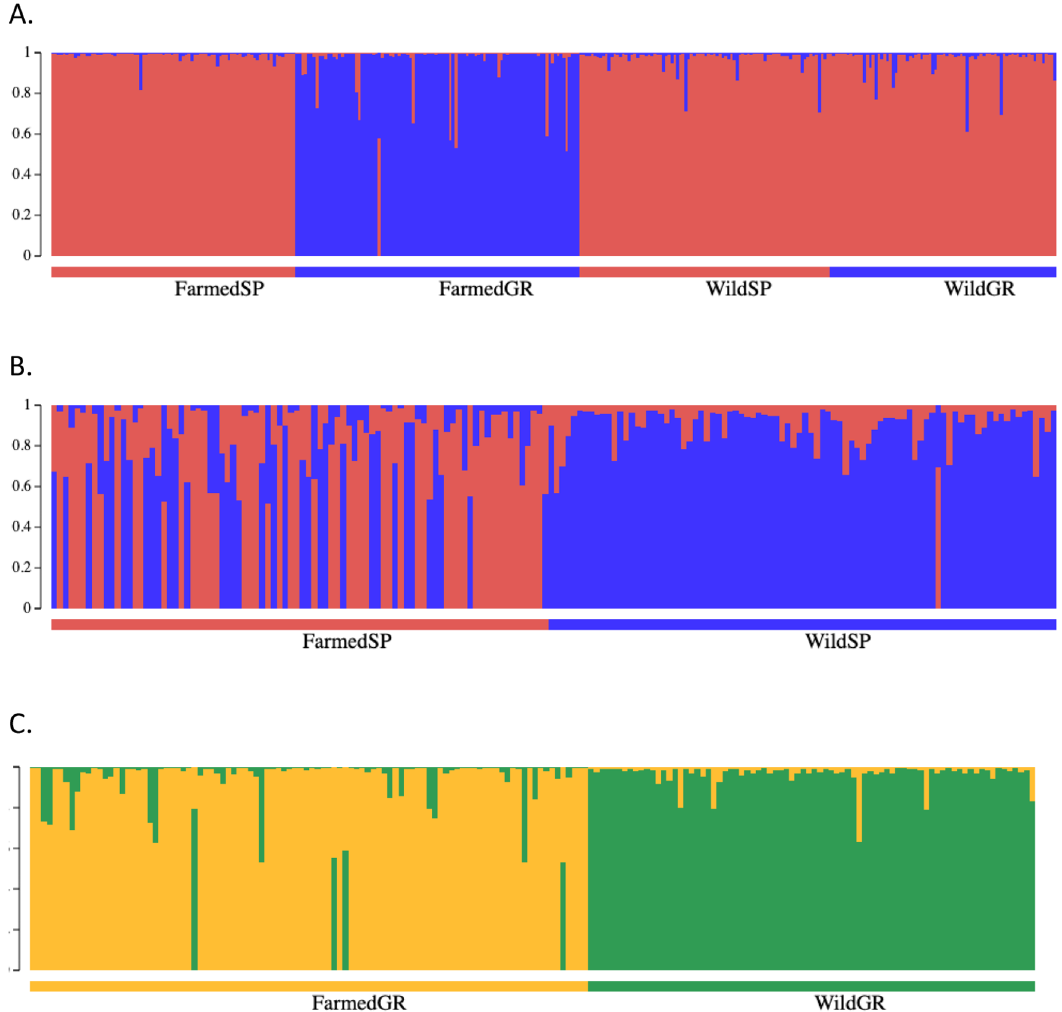
Fig. 3. Bayesian clustering of S. aurata samples. A. All four samples form two clusters. B. Spanish samples. C. Greek samples. The different colors represent the groups that the program STRUCTURE has clustered the individuals. The length of the colored bar shows the probability that a speci fi c individual belongs to the respective group. The length of the colored bars per individual adds up to